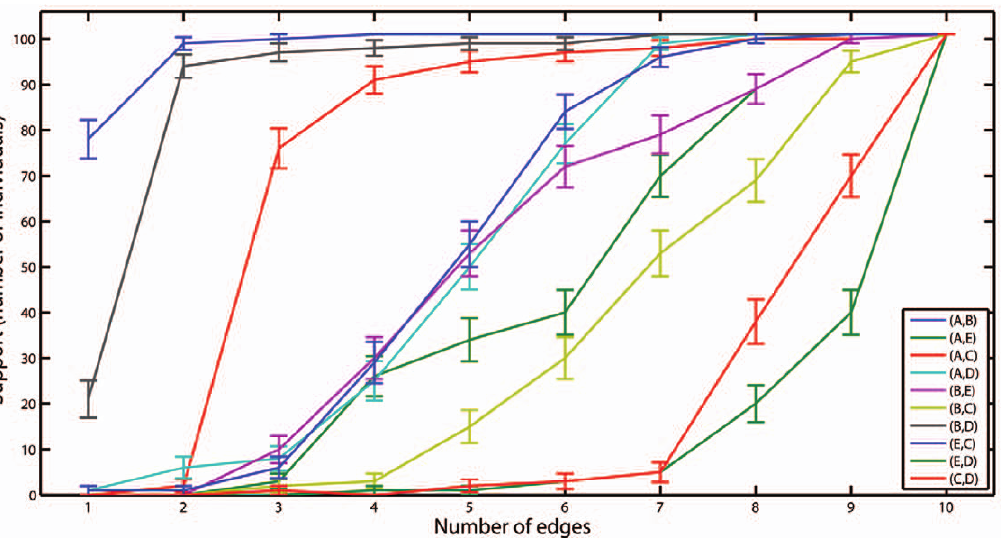
Figure 4. Level of support of each edge in all individual best-fitting models with fixed number of edges. The results are for BIC scores in human.